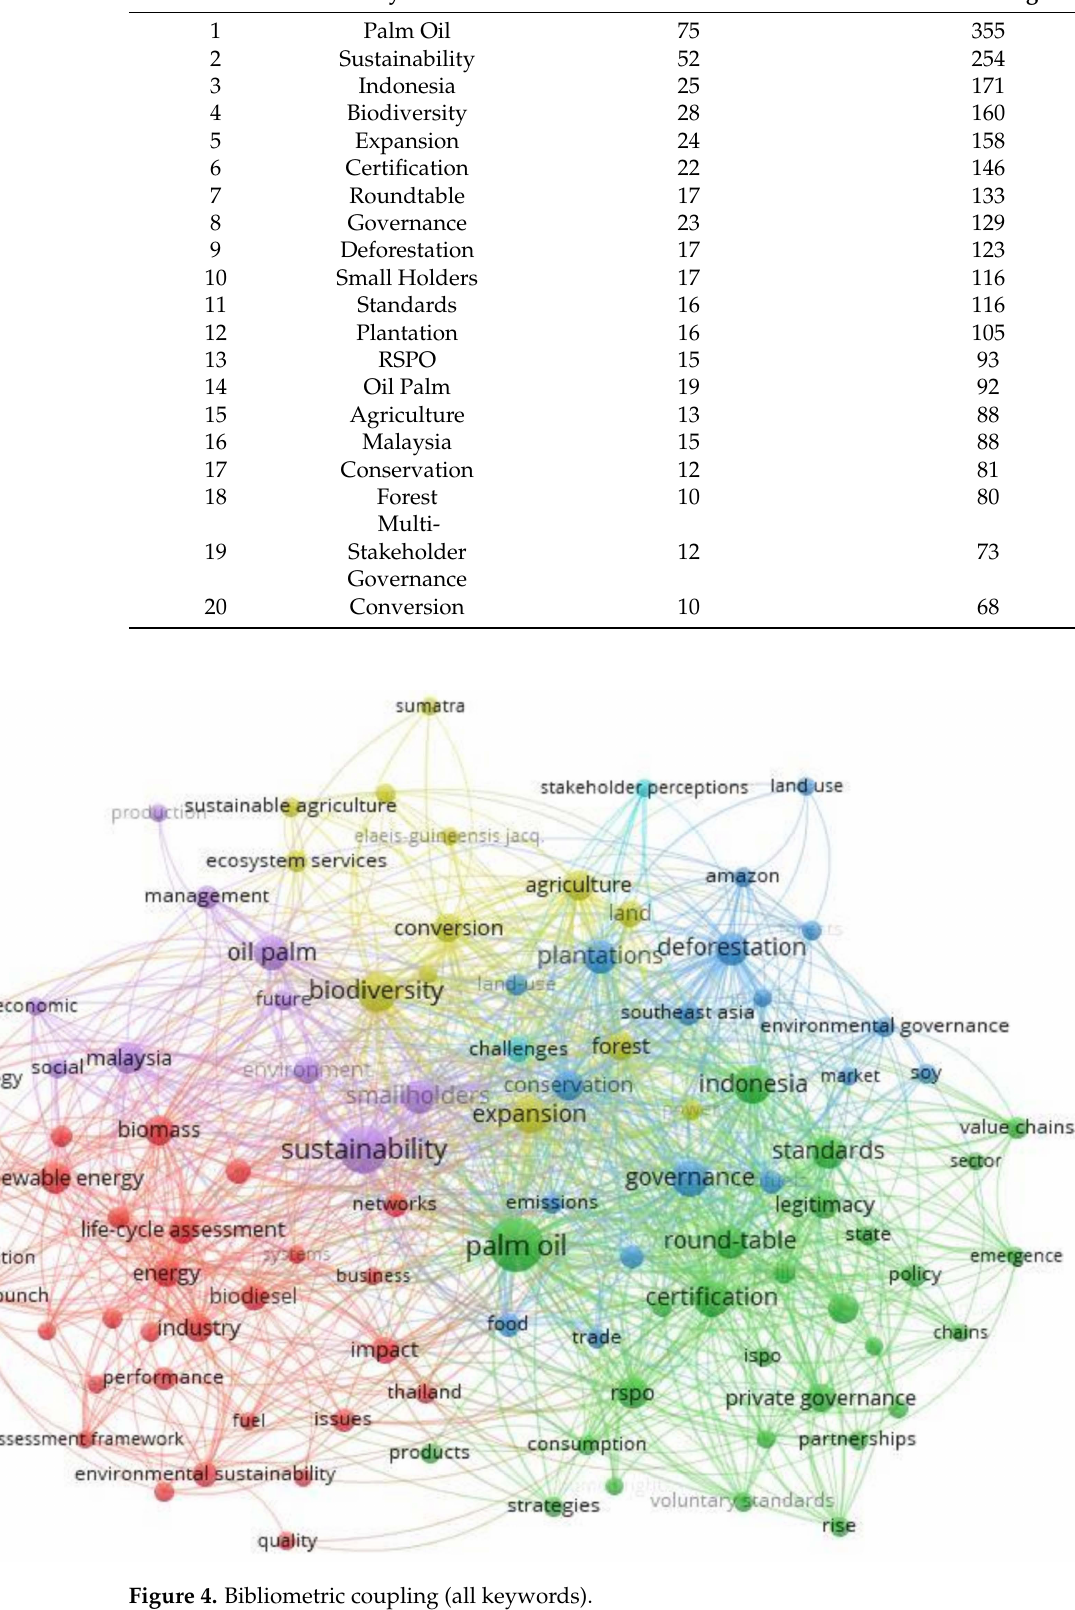
Figure 4. Bibliometric coupling (all